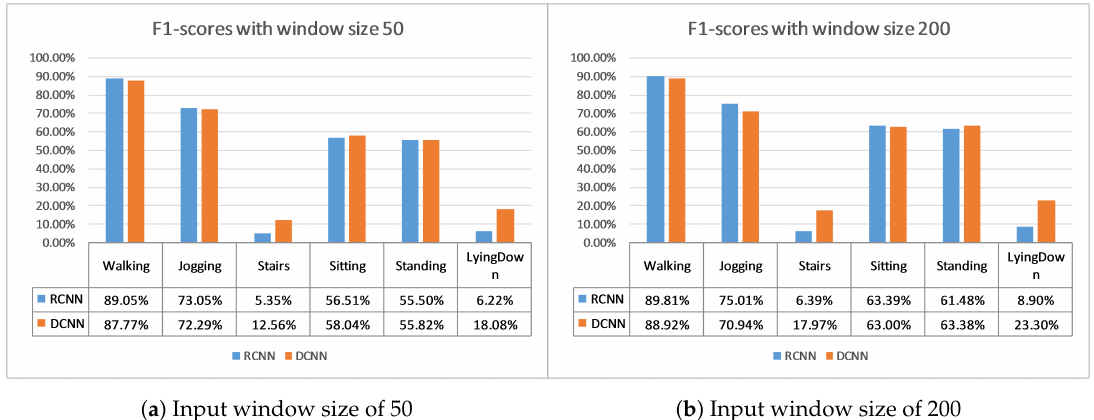
Figure 7. Average f1-scores of the 10-fold cross-validation of the Actitracker